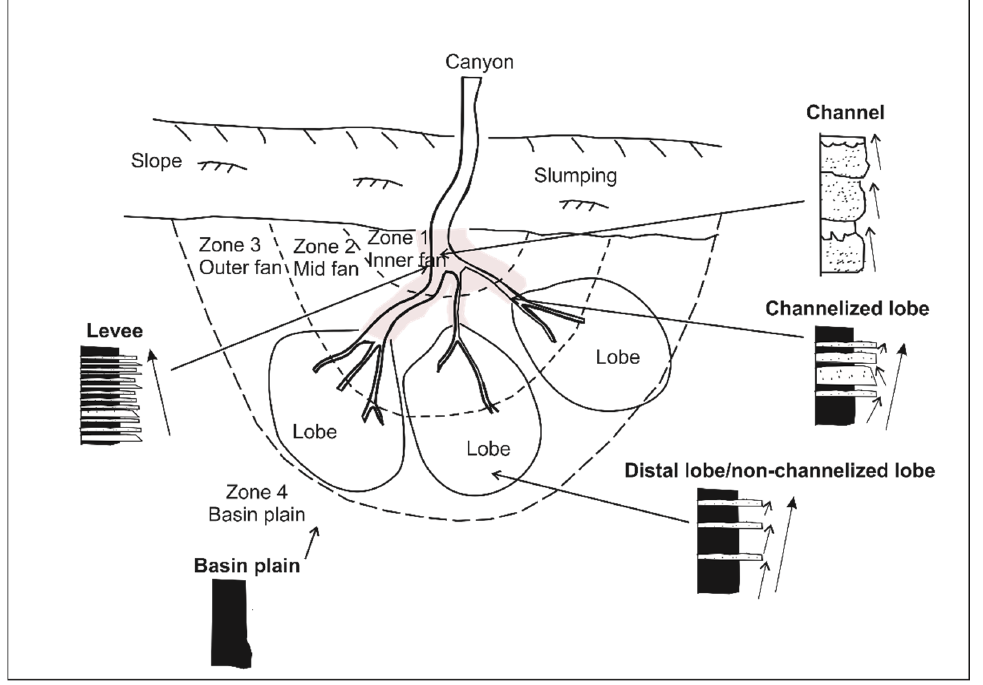
Figure 8. The depositional setting for each component of the facies association interpreted in the study area. Channel shows a fine-upward sequence located in the inner fan (zone 1) part; the levee shows a fine-upward sequence located in the outer channel in the inner and mid fan (zone 1 and zone 2); the channelized lobe shows a coarsening-upward sequence located in the proximal lobe with the presence of a distributary channel, which can be found in the mid fan (zone 2); the distal lobe/non-channelized lobe shows the coarsening-upward sequence located in the distal lobe and no distributary channel are present, which can be found in the outer fan (zone 3); the basin plain is located in the outer of the turbidite fan system.